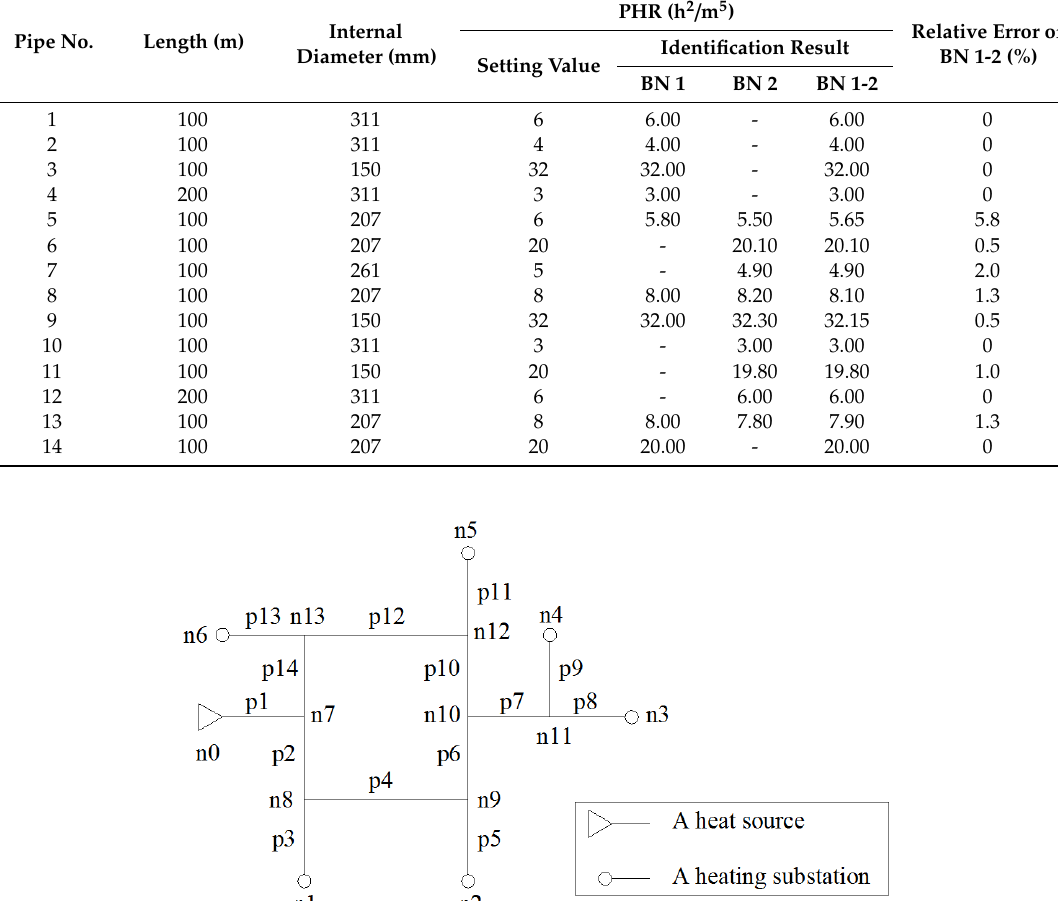
Table 5. Pipes information and PHRs identification results of the example loop DHN.